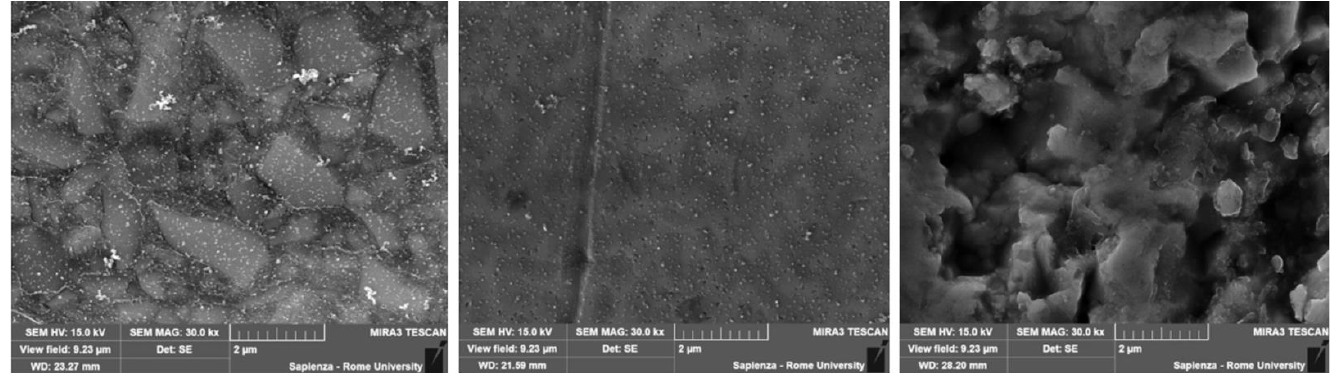
Figure 3. SEM analysis showed different surface characteristics of the tested materials: PINC (on the left) showed uniform wear with a low visual roughness, even if an initial enucleation of some filler particles and some signs of subsuperfical cracks could be observed. LS (in the centre) showed mineral particles on the surface, which could enhance the roughness and, therefore, the abrasive effect towards the antagonist enamel. The cubic zirconia (on the right) showed a superficial delamination, which made this material less rough and, consequently, less aggressive towards the enamel.